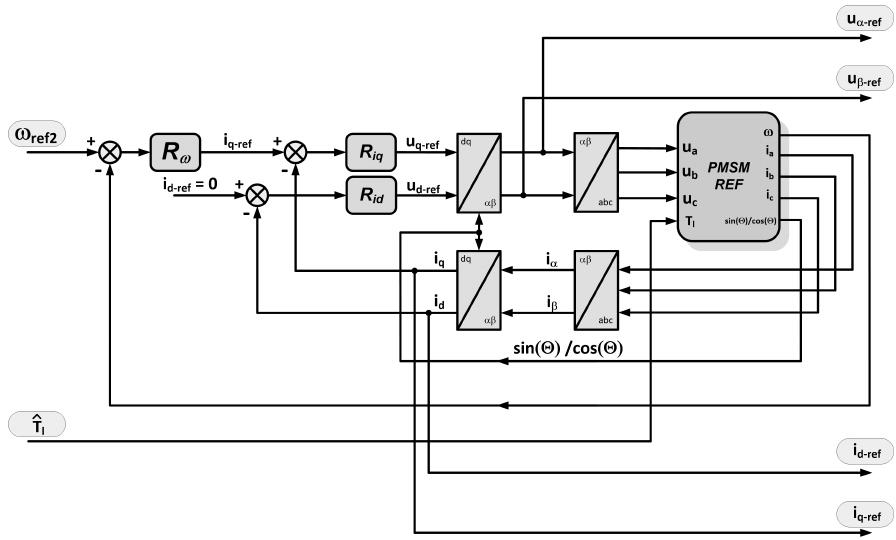
Figure 3. Inner structure of the PMSM drive reference (Figure 2, Module 2) block.